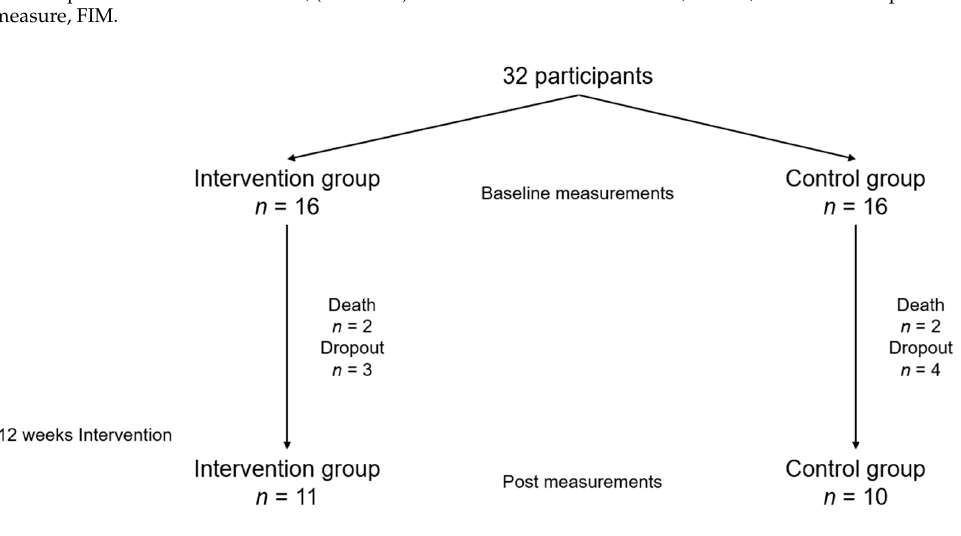
Figure 1. Flow chart for this study.